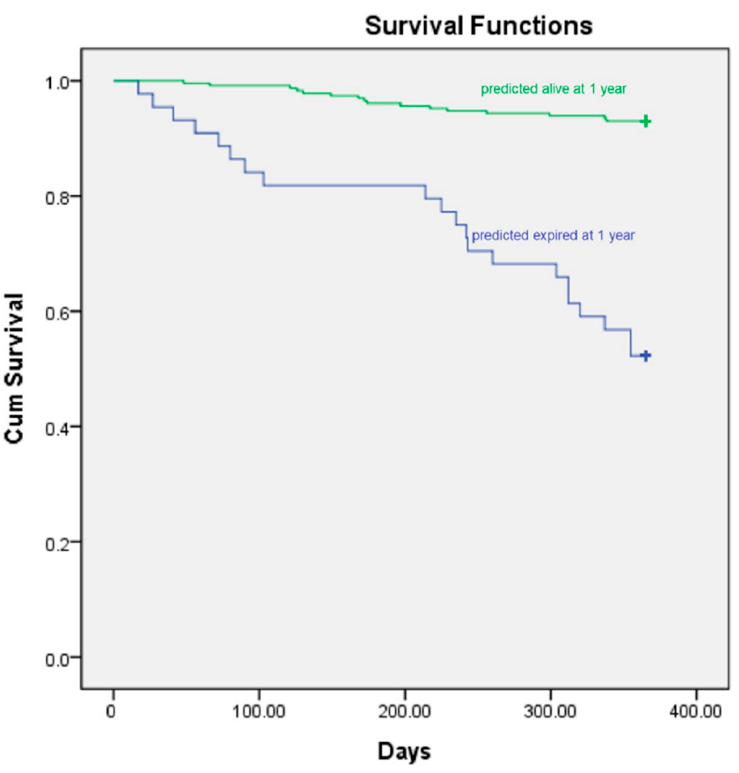
Figure 1. Prognostic significance of PET-CT base prediction results.